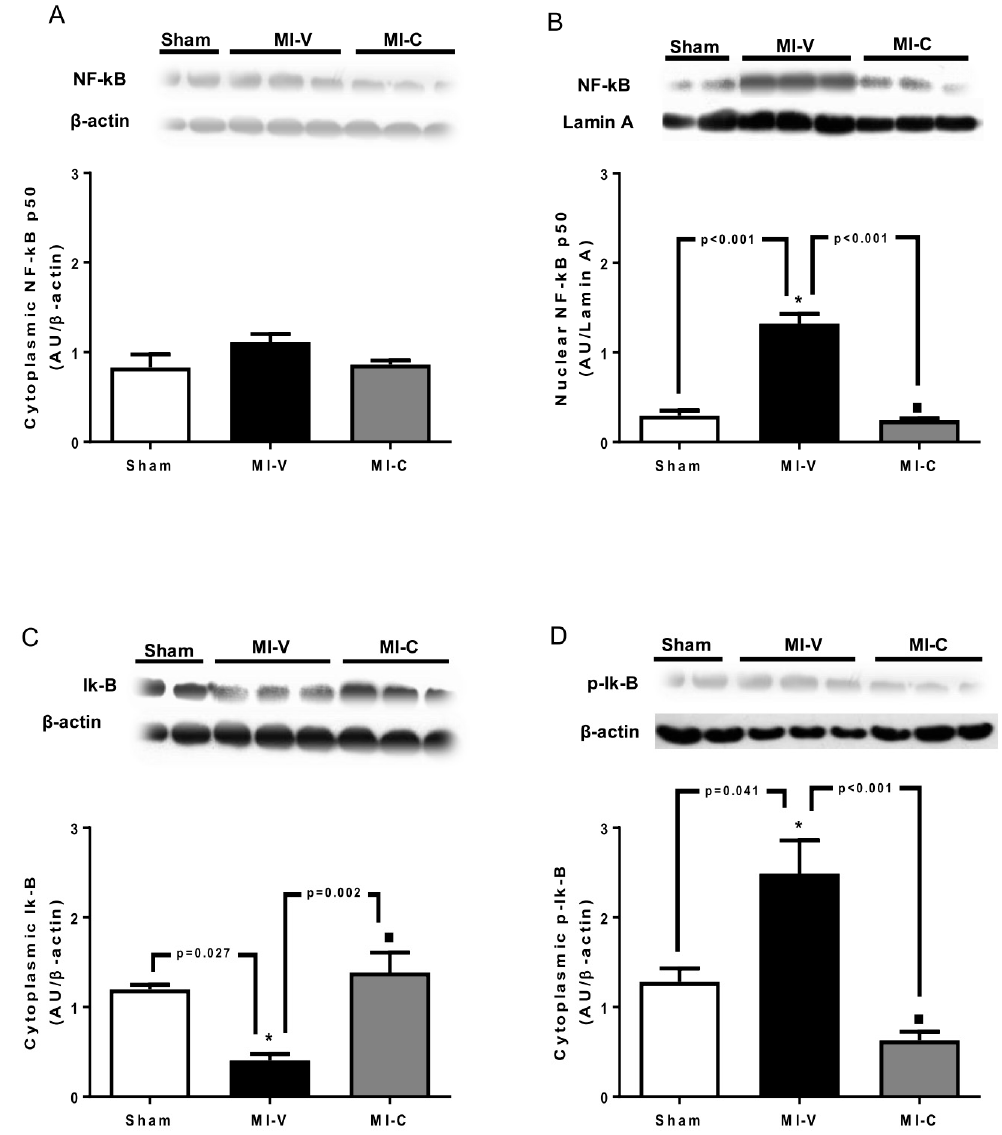
Figure 3. Effect of clofibrate on the activation of NF-kB. The protein expression of ( A ) cytoplasmic NF-kB p50, ( B ) nuclear NF-kB p50, ( C ) cytoplasmic Ik-B, and ( D ) cytoplasmic p-Ik-B was determined in left ventricles from Sham, myocardial infarction (MI)-vehicle treated (MI-V), and MI-clofibrate treated (MI-C) rats. β -actin was used as load control for cytoplasmic and Lamin A for nuclear load control. Images corresponding to β -actin were re-used for illustrative purposes. Bars represent the mean ± standard error; n = 6 rats per group, ANOVA-Tukey * p < 0.05 vs. Sham and (cid:4) p < 0.05 vs. MI-V. It is well known that inflammatory molecules exert a stimulus on the intrinsic apoptotic pathway. Therefore, we evaluated the expression of apoptotic proteins Bad, p-Bad, and Bax, and antiapoptotic proteins Bcl-2 and 14-3-3 ε . As observed after 14 days of MI, the expression of antiapoptotic protein significantly augmented compared with Sham. Total Bad did not show a significant change in its expression among the different groups. Contrasting with this, clofibrate treatment was able to increase the MI-induced fall in the expression of Bcl-2 and 14-3-3 ε and to decrease Bax and p-Bad in the studied left ventricles (Figure